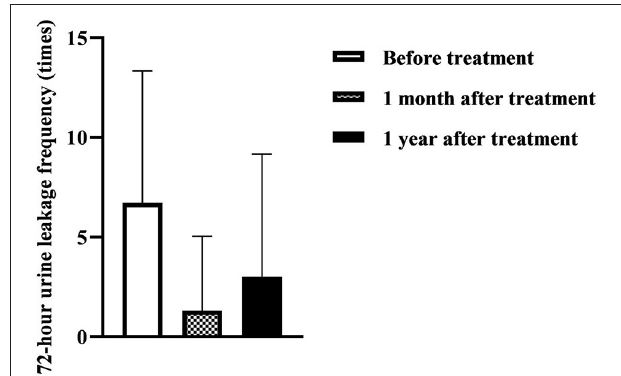
FIGURE 3 | 72-h urine leakage frequency at 1 month and 1 year after treatment with Modified Buzhong Yiqi Decoction ( n = 90).